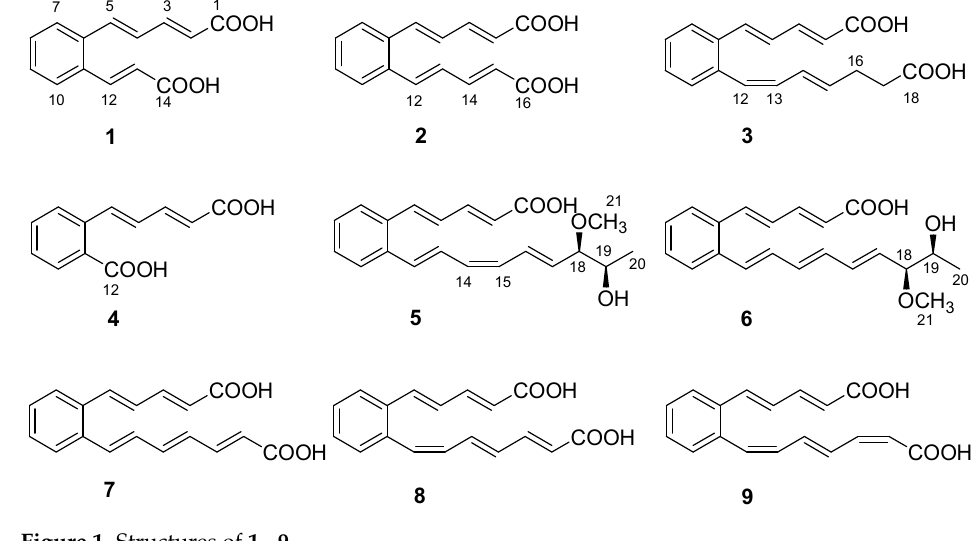
Figure 1. Structures of 1 − 9 .